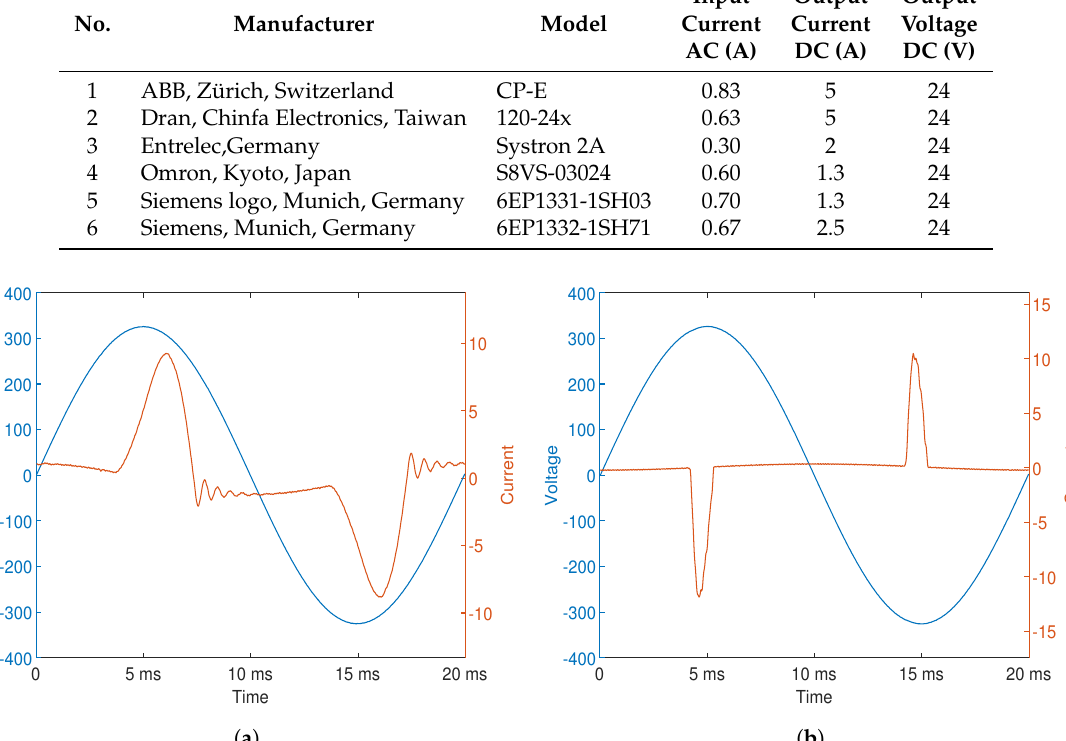
Figure 2. Current waveform drawn by SMPS ( a ) Type 1 ( b ) Type